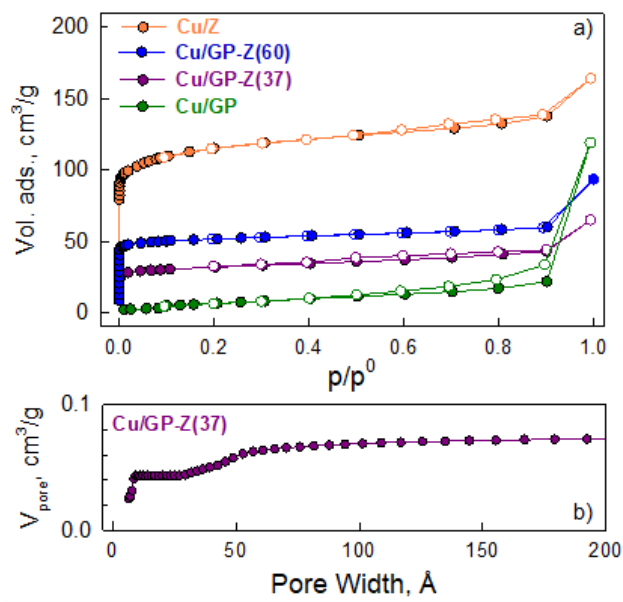
Figure 3. ( a ) N 2 adsorption/desorption isotherms at 77 K over pure Cu/GP and composite Cu/GP – Z(x) monoliths and reference Cu/Z powder; ( b ) Cumulative pore volume as a function of the characteristic pore width for the Cu/GP – Z(37) monolith.